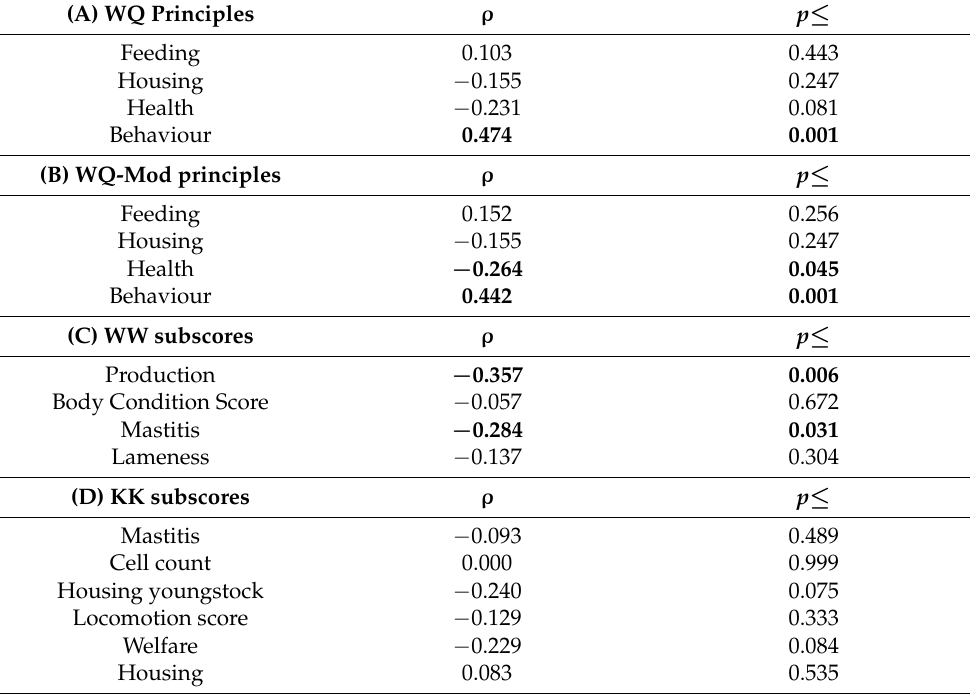
Table 3. Spearman rank correlations (Rho, ρ ) and associated probabilities ( p -values, printed bold if p ≤ 0.05) between cortisol and (A) WQ principles, (B) WQ-Mod principles, (C) WW subscores, (D) KK subscores, (E) CWM scores and (F) CCSS chapters (all variables at herd